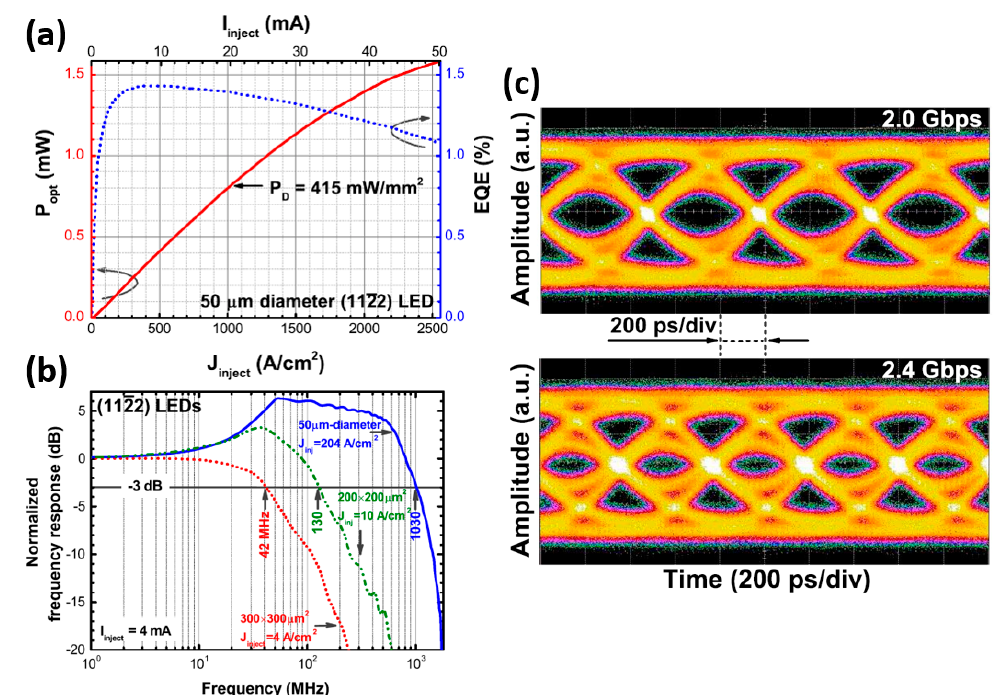
Figure 3. ( a ) P opt and corresponding EQE of the LED plotted as a function of I ( J ) inject ; ( b ) normalized frequency response curves of the non-mesa-etched 50 µ m diameter, 200 × 200 µ m 2 , and 300 × 300 µ m 2 (11-22) LEDs measured at different J inject ( I inject = 4 mA); (c) eye diagrams at 2 Gbps and 2.4 Gbps of an LED with a non-mesa-etched 50 µ m diameter (11-22) measured at I inject = 10 mA. [57] Figures reproduced with permission from Optical Society of